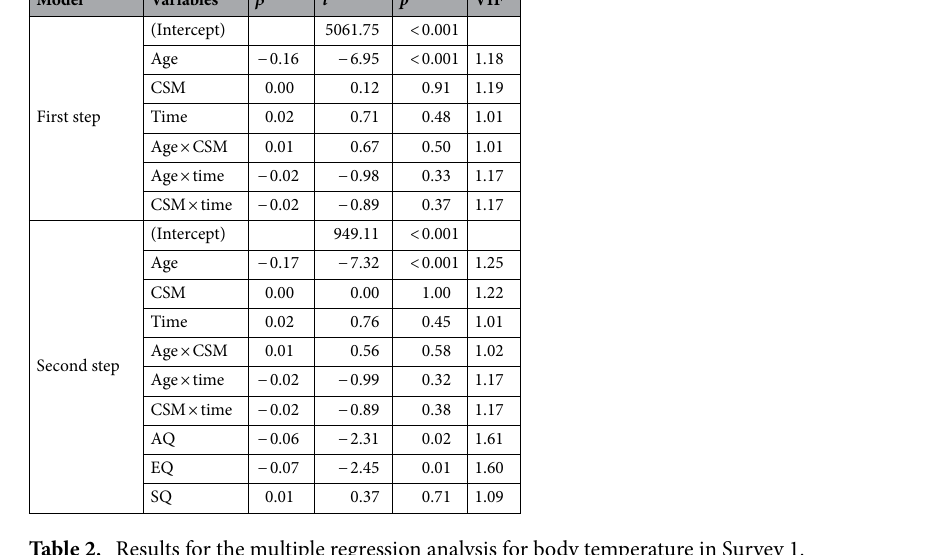
Table 2. Results for the multiple regression analysis for body temperature in Survey